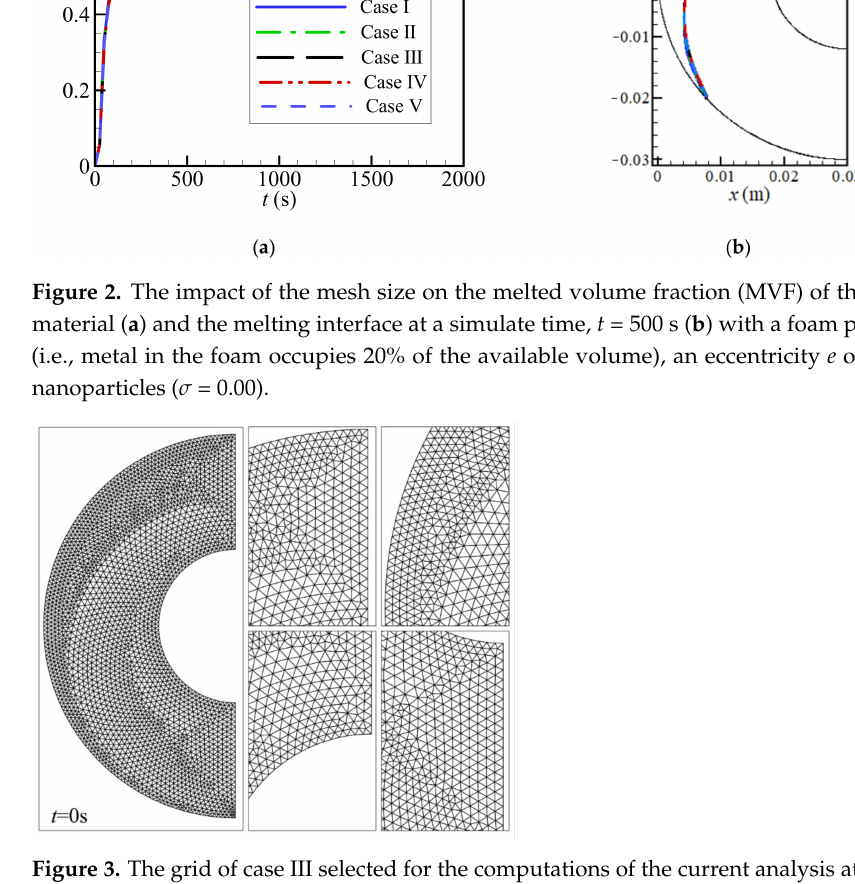
Figure 3. The grid of case III selected for the computations of the current analysis at t = 0 s.